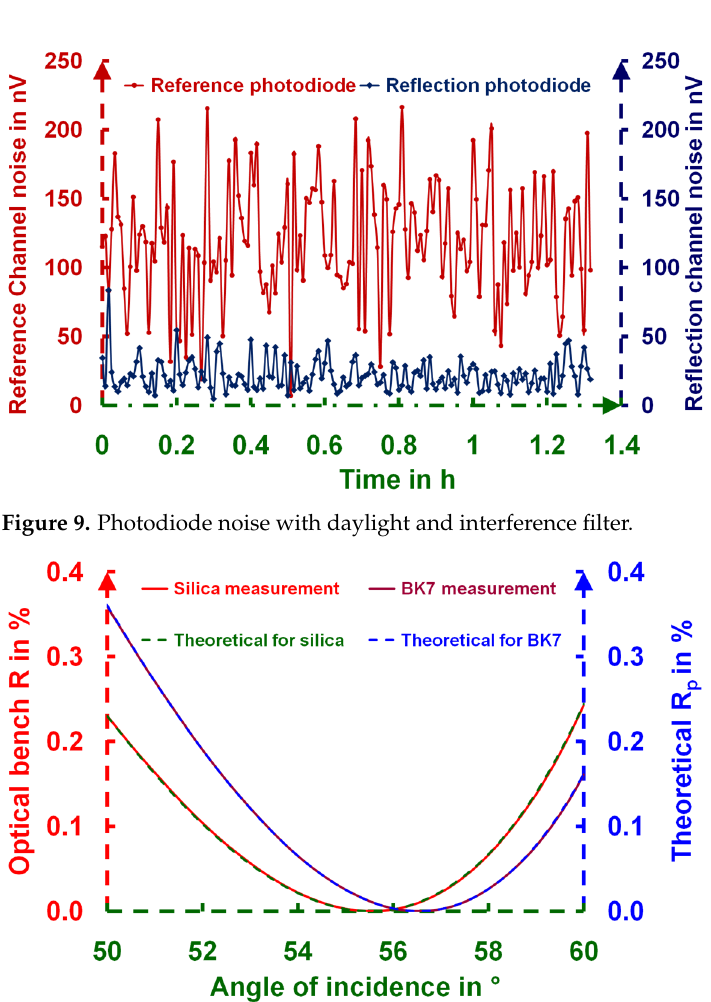
Figure 8. Signal fluctuations with a ratio between the reflection and the reference signals over 9 h.